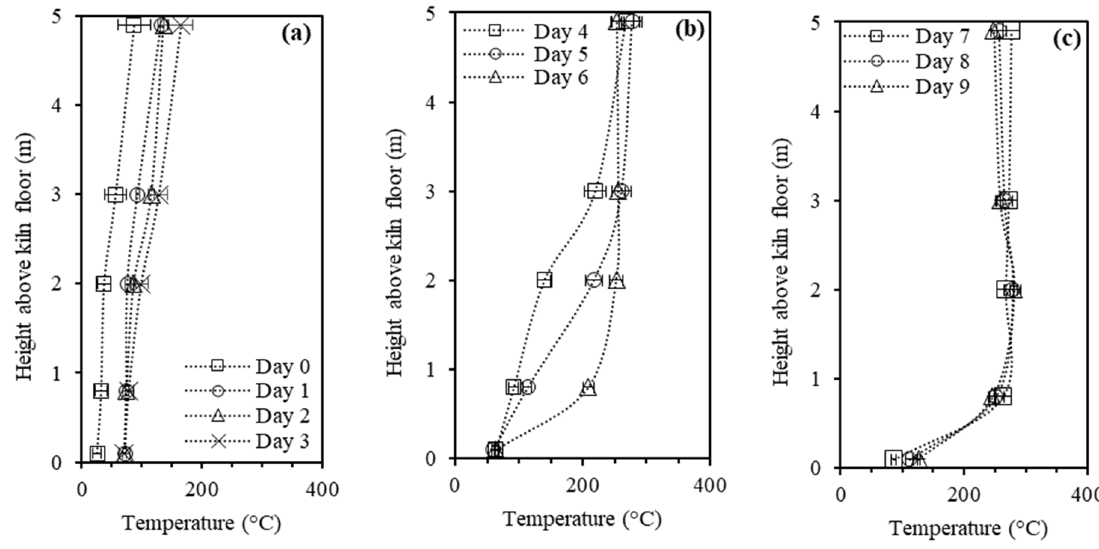
Figure 4. Vertical temperature profiles at the rear part of the kiln during Test 1, from day 0 to day 9, as measured by thermocouples T14 (0 m) to T18 (5 m). ( a ) from day 0 to 3, ( b ) from day 4 to 6, and ( c ) from day 7 to 9.